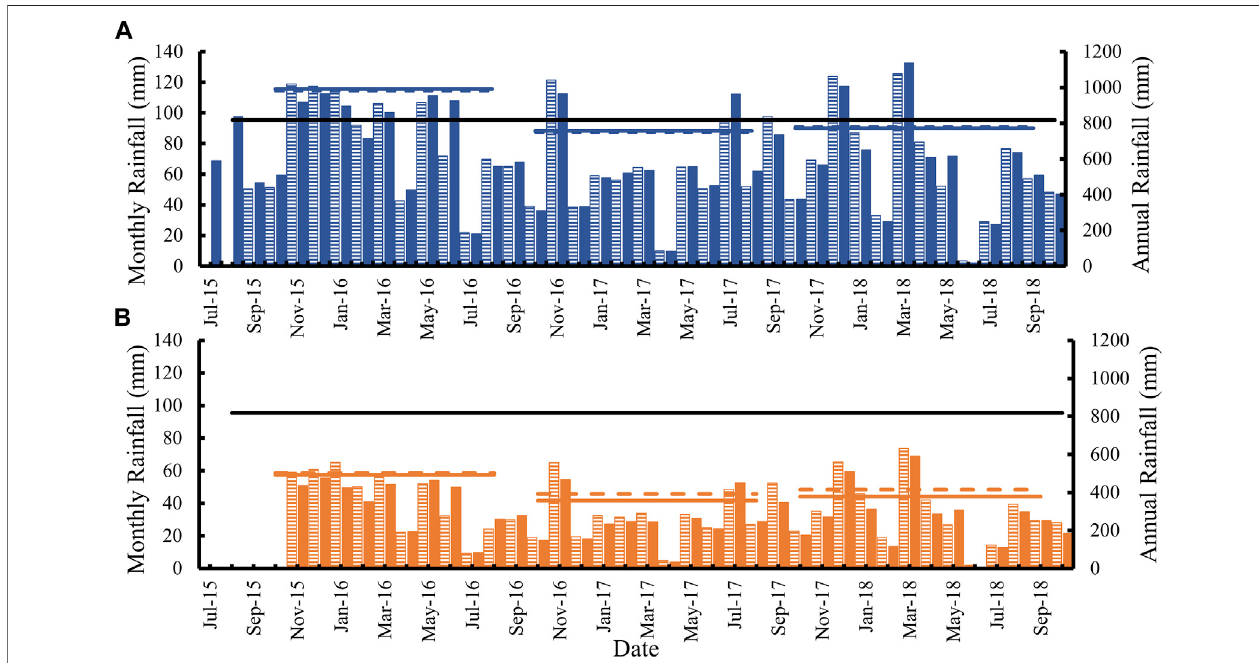
FIGURE3| Monthlyandannualtotalrainfall(mm)for (A) ControlplotsatUniversityoftheWestofEngland(UWE)andOldwoodPit(OWP)and (B) forreducedrainfall (RR) plots at UWE and OWP. Long-term total annual rainfall for the Frome catchment (1961 – 2017) is shown for comparison. In this study, the year was de fi ned as